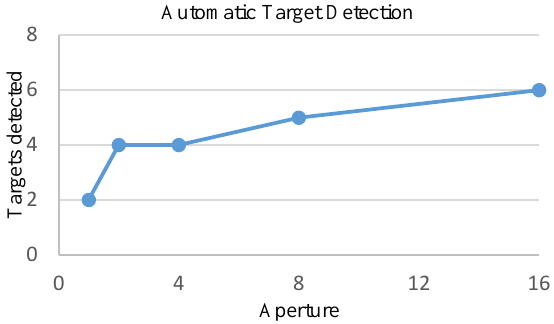
Figure 5. Forensic Scene: Lytro images, influence of aperture. The distances measured in the f/16, f/2 and f/1 dataset showed discrepancies of under a millimetre for all datasets (Table 3).